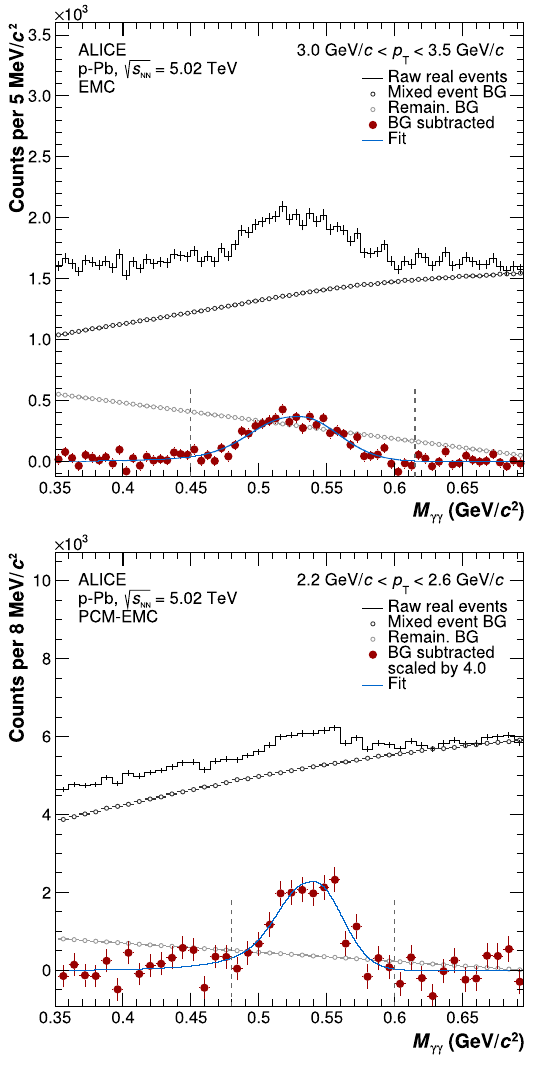
Fig. 2 The diphoton invariant mass distribution around the η mass for selected intervals in p T , without and with combinatorial background for each of the three measurements: EMC, PCM, and PCM-EMC. The